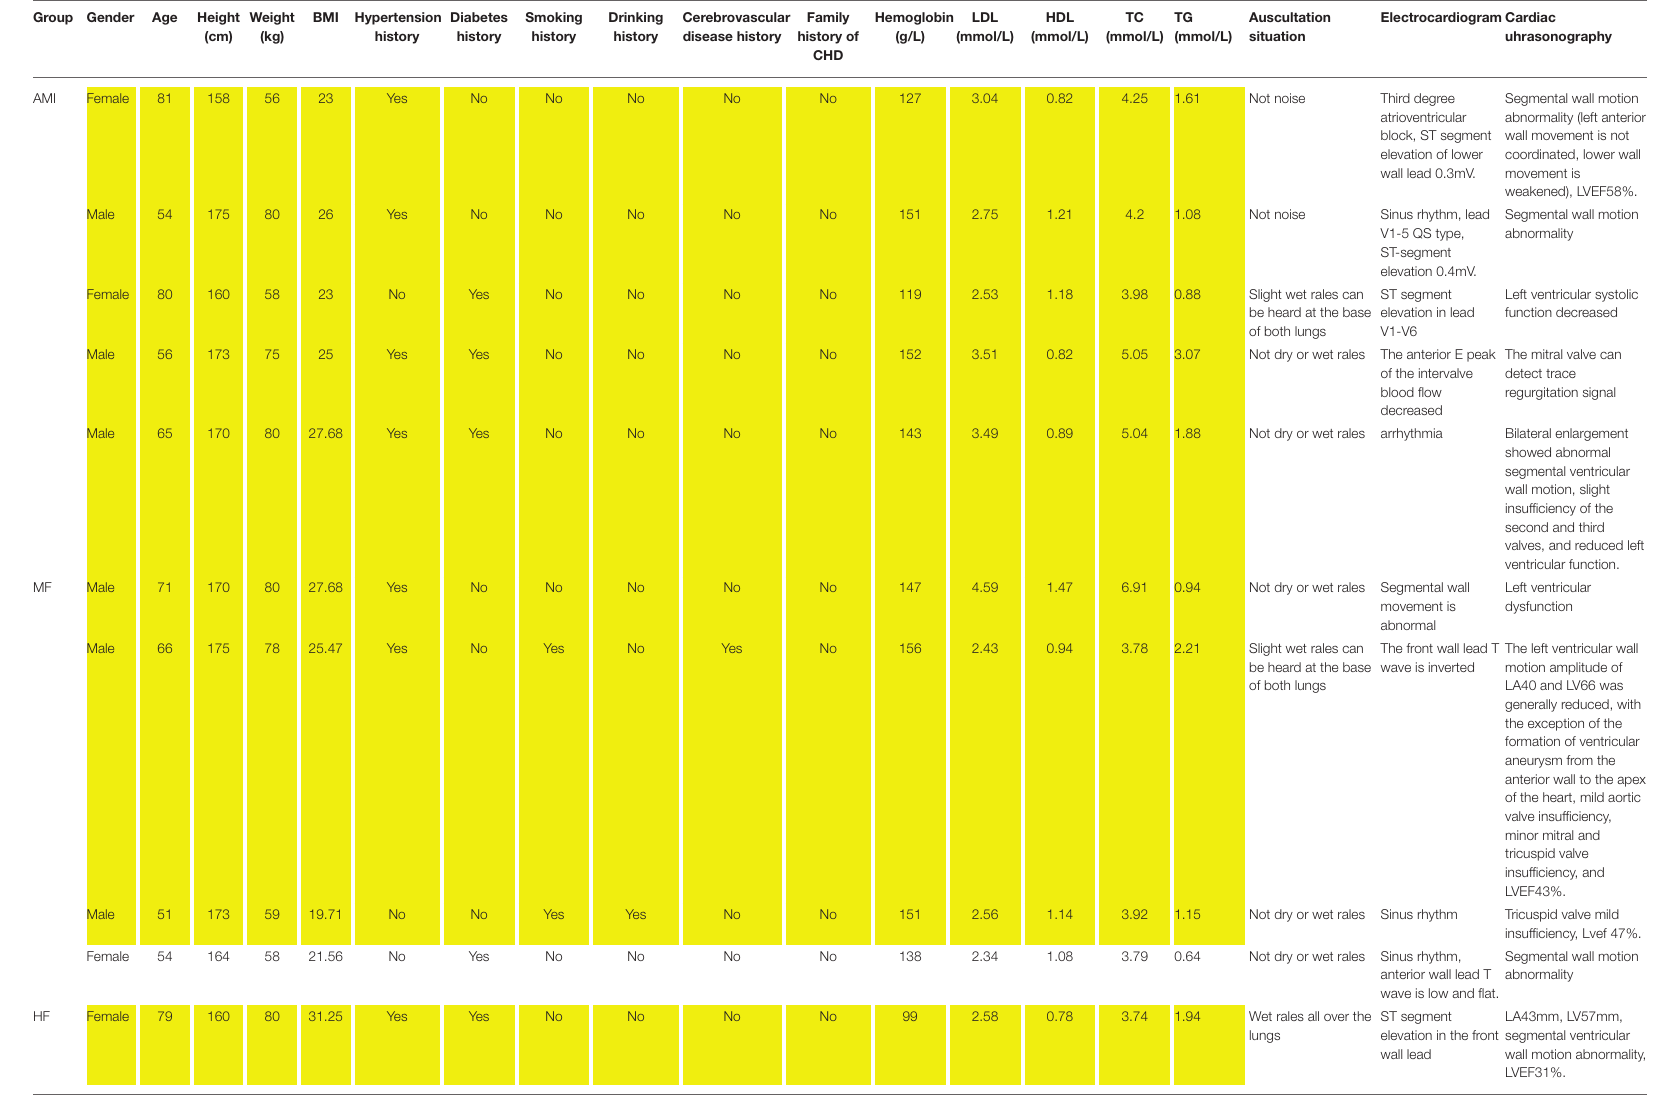
TABLE 1 | The clinical information of all individuals enrolled in RNA sequencing and in vitro validation. Group Gender Age Height Weight (cm) (kg)